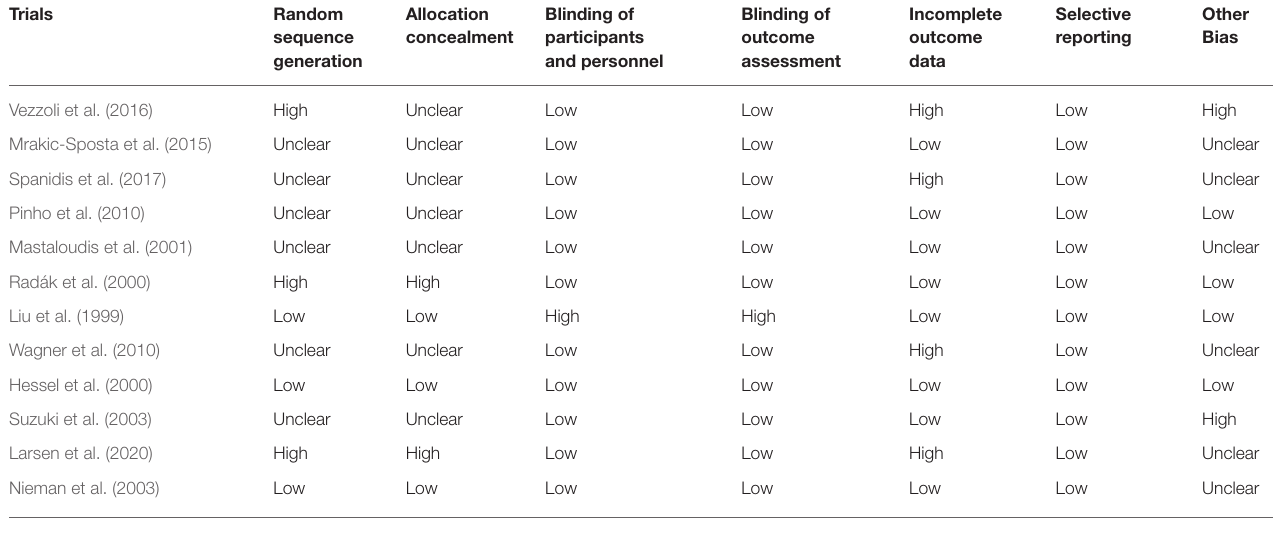
TABLE 2 | Risk of bias evaluation of included studies.